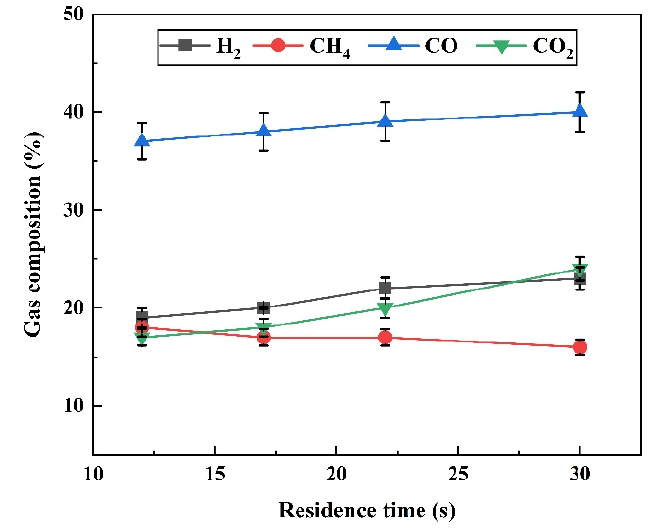
Figure 2. Effect of residence time on pyrolysis gas composition of pine sawdust at 850 °C without catalyst.